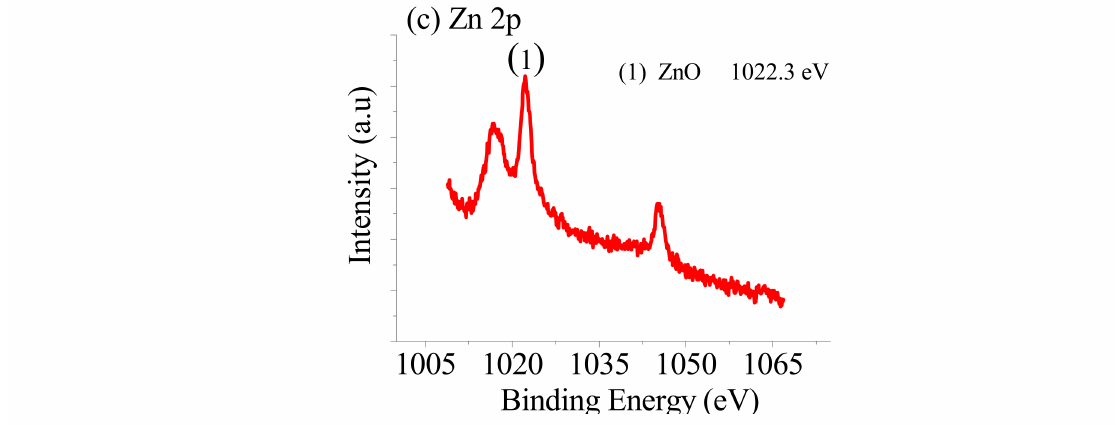
Figure 5. The XPS profile of the ZnPSi for ( a ) Si2p (103.5 eV), ( b ) O1s (532.84 eV), and ( c ) Zn2p (1022.3 eV).